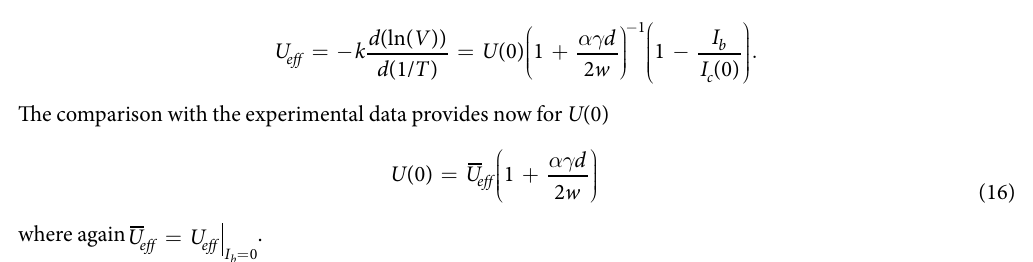
. eff I 0 b As summarized in Table 2, in which αγ ~ 63, the obtained values of U (0), ~87 meV and ~233 meV for sample